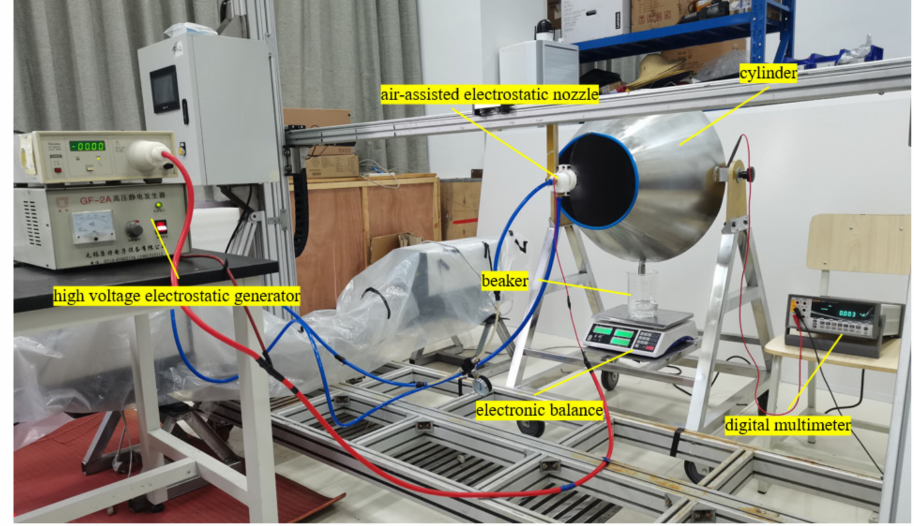
Figure 4. Experimental set-up to measure the charge-to-mass